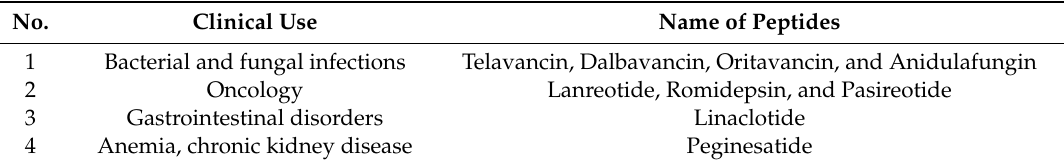
Table 2. FDA approved cyclic peptides and their clinical